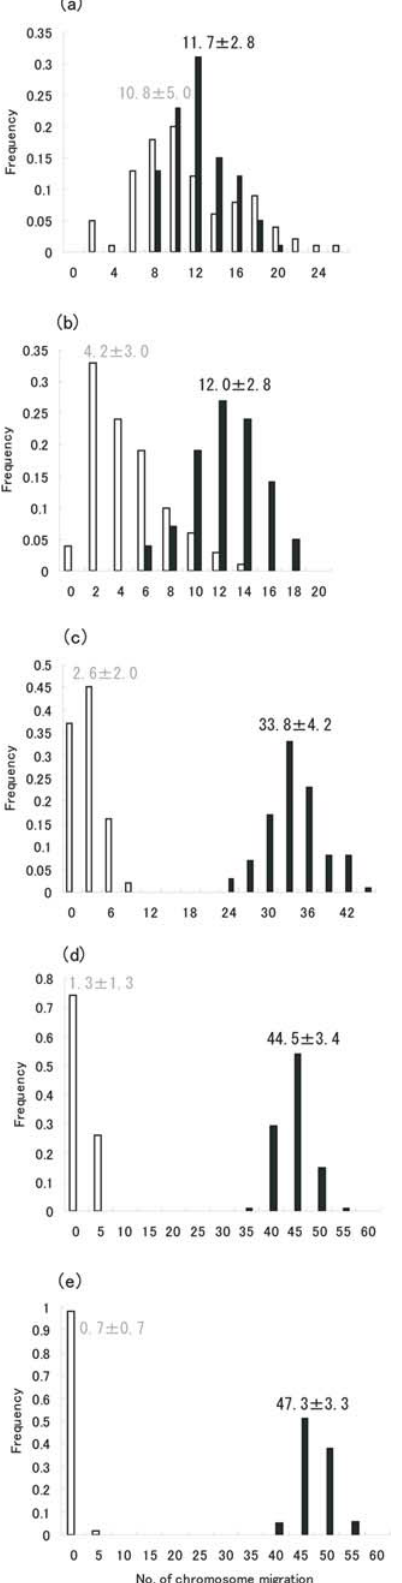
Figure 1. The number of chromosomal migrations of mouse OR genes before (black bars) and after (white bars) the Amphibia- Mammalia (a), Aves-Mammalia (b), Monotremata-Placentalia (c), Marsupialia-Placentalia (d) and Laurasiatheria-Euarchonto- glires (e) split, respectively based on the bootstrap analysis. The distribution of the number of chromosomal migrations was calculated by repeating the bootstrap resampling procedure [28] 100 times and by constructing the phylogenetic tree for each resampling procedure based on the neighbor-joining method [29]. Mean 6 standard deviation is shown in the figure. In mammals, only class II ORs were taken into account because all class I ORs are located in the same chromosomal region